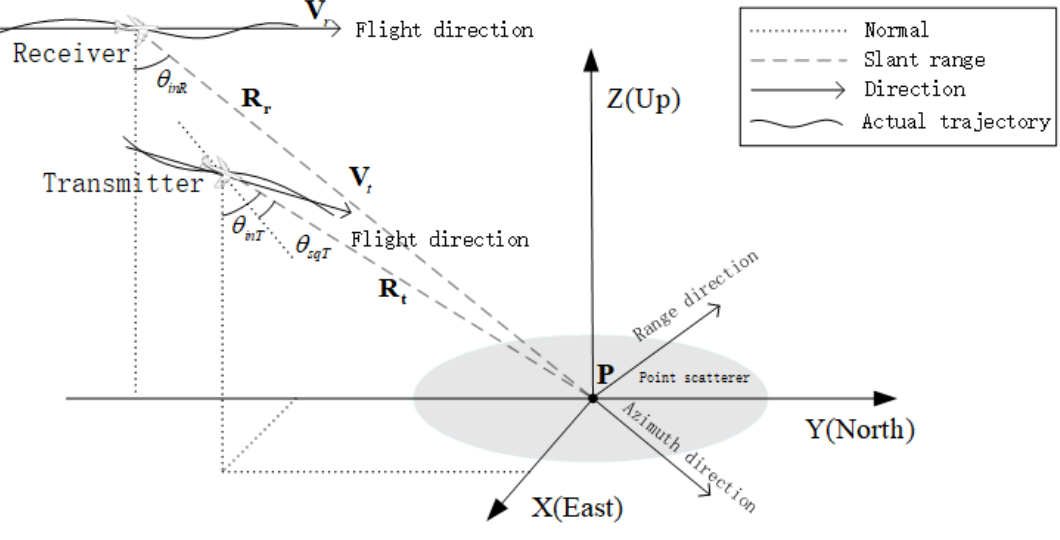
Figure 1. Mini-UAV-based BFSAR